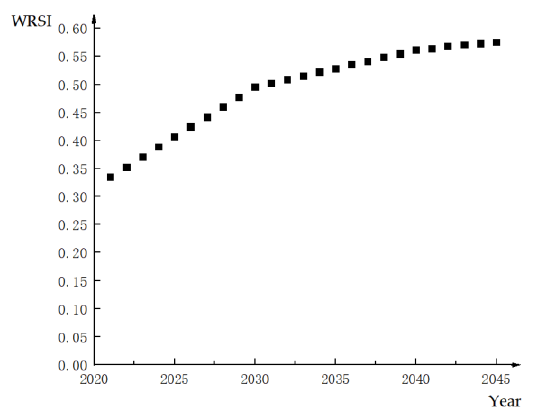
Figure 4. Change trend of WRSI in Helan.